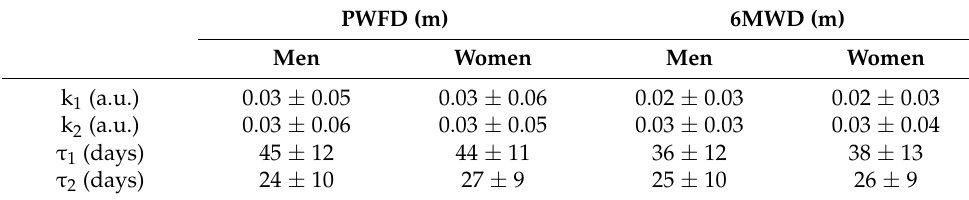
Table 5. Model parameters for the two parameters in men and